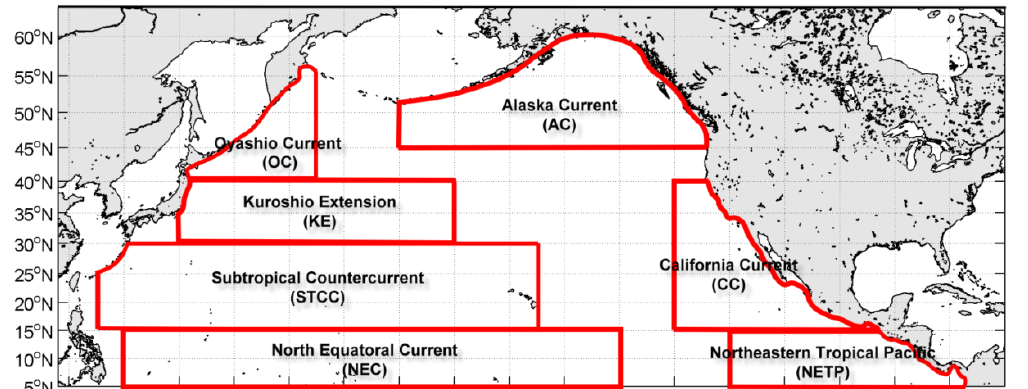
Figure 5. Map of active regions in the North